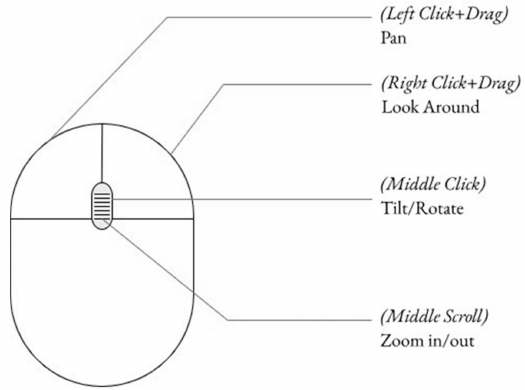
Figure 6. Mouse interactions built using a custom C# script for Bird Eye View